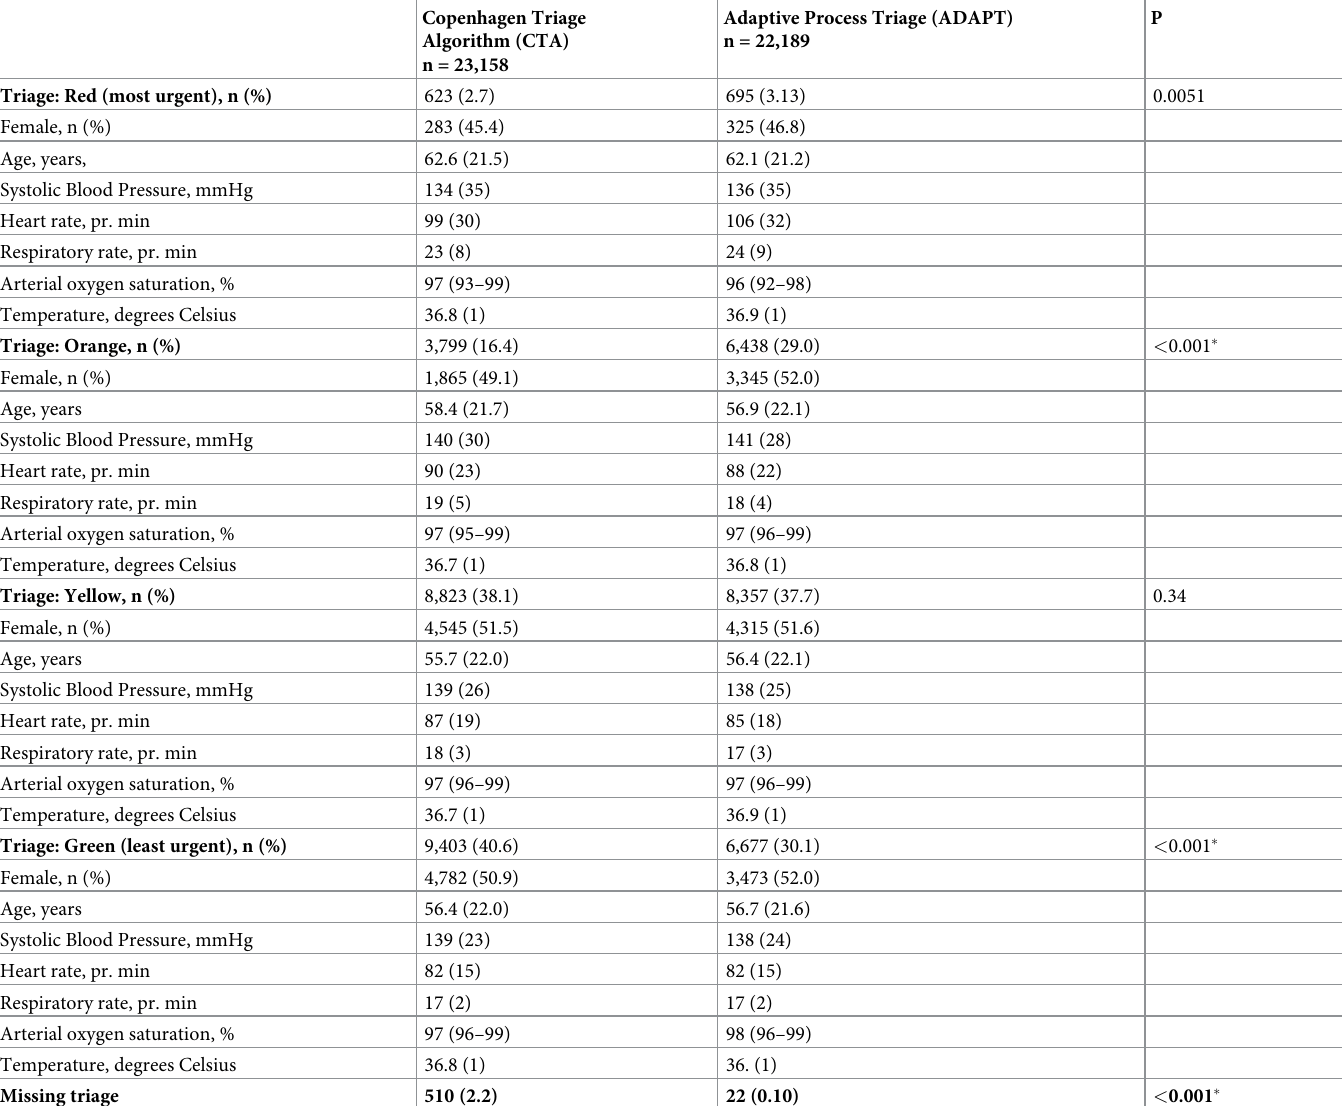
Table 1. Baseline characteristics divided into triage levels. Baseline characteristics and vital signs for patients admitted to the emergency department and triaged with two different systems., mean values (Standard deviation) across triage levels, arterial oxygen saturation: median